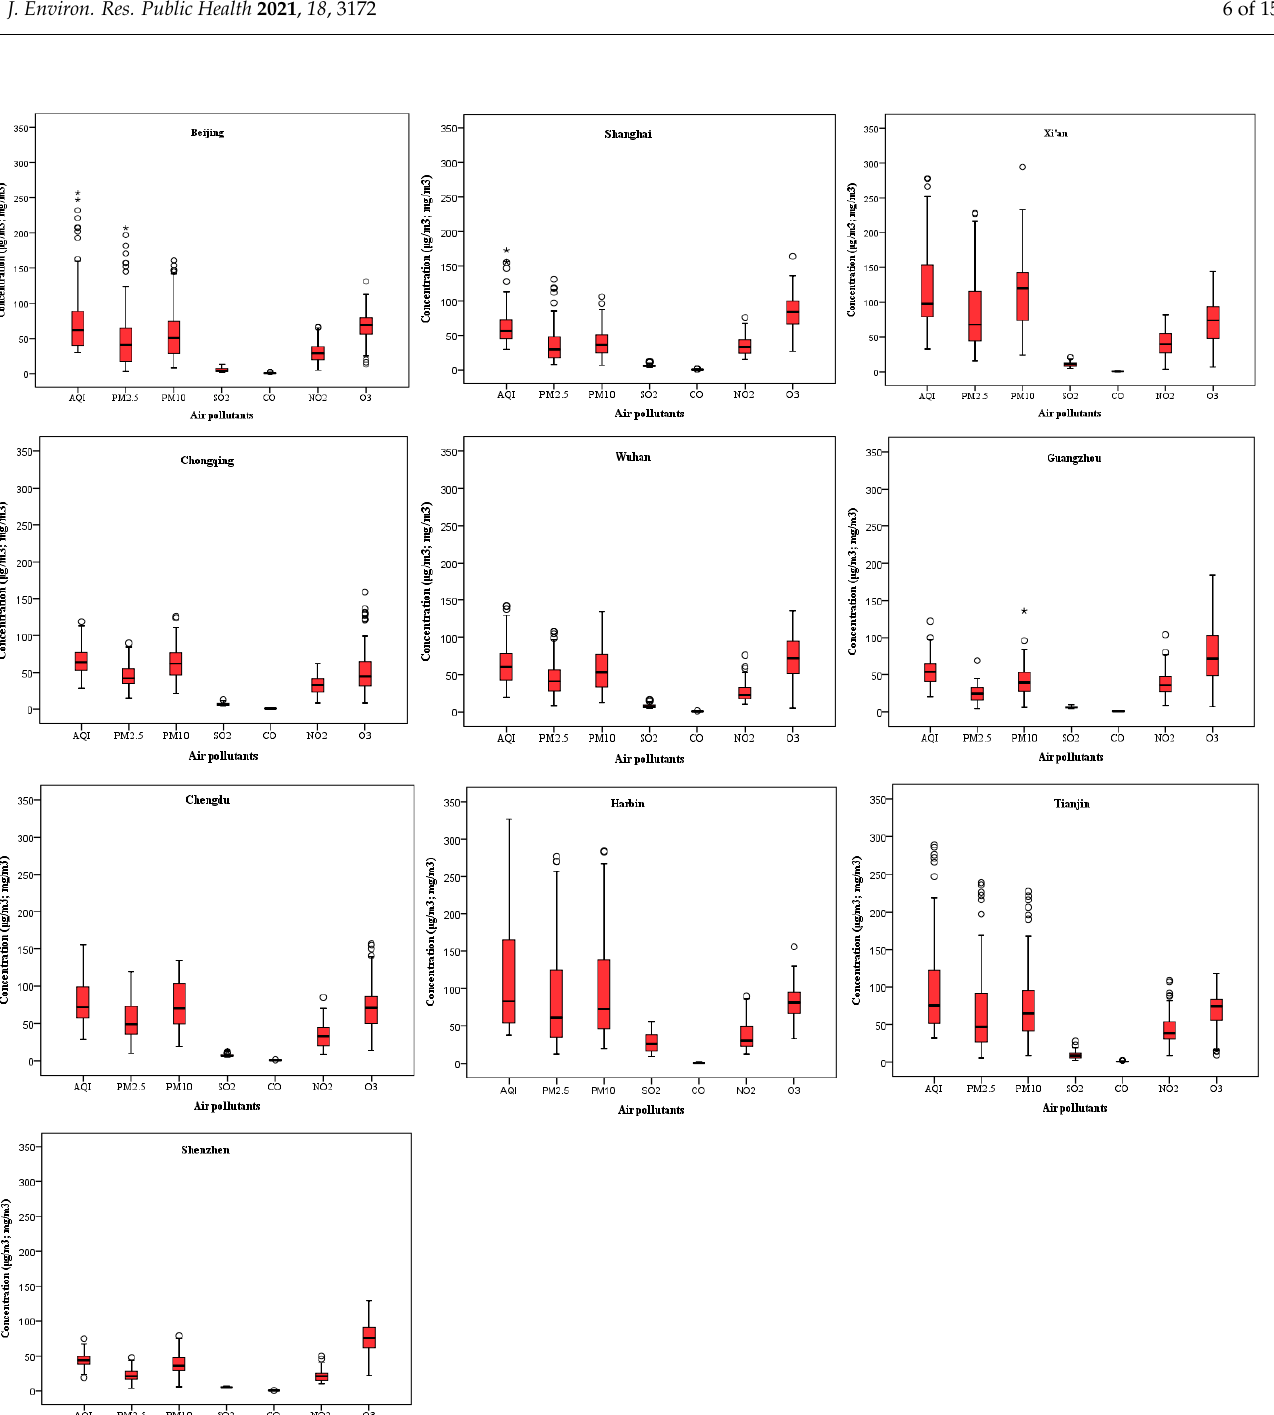
Figure 2. A visual summary of AQI scores and air pollutants concentration in 10 major Chinese cities during the initial phase of the COVID-19 outbreak (lockdown period), showing the minimum, median, maximum, lower quartile, and upper quartile value of each parameter.